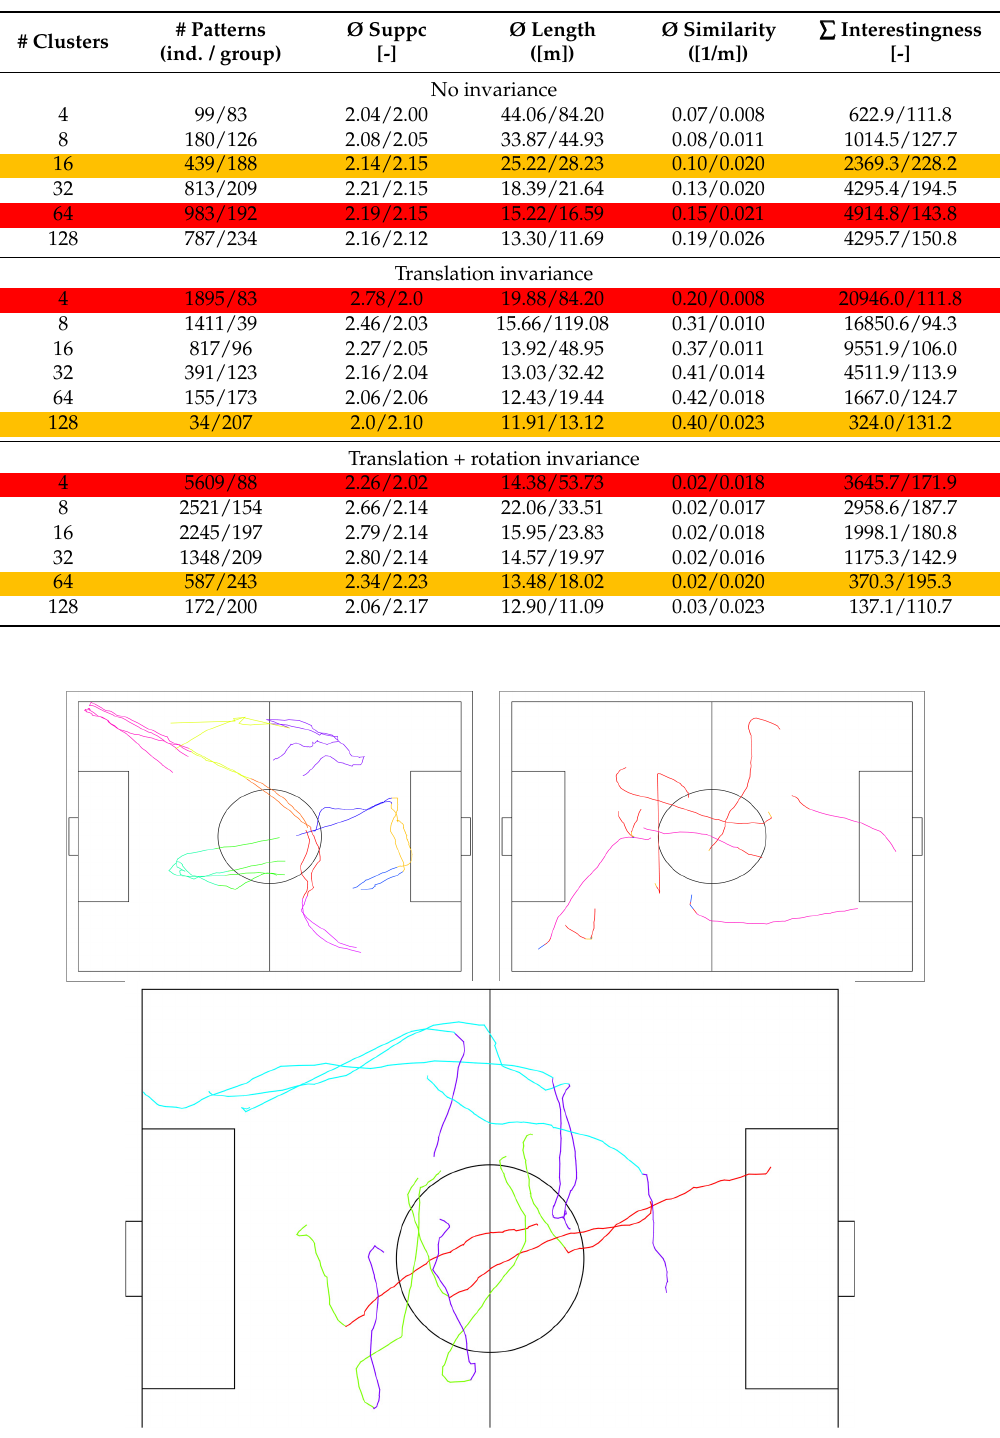
Table 3. Influence of the number of clusters on the resulting (individual/group) patterns. Maximum interesting values for individuals are highlighted in red, for groups in yellow.